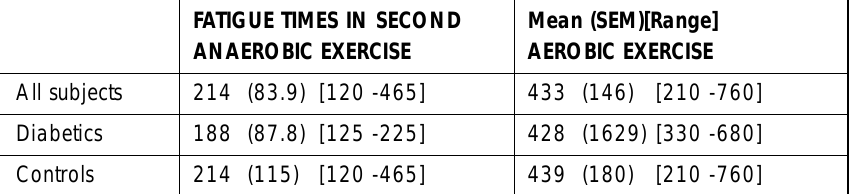
Table 3: Comparison of time to Fatigue during the Performance of